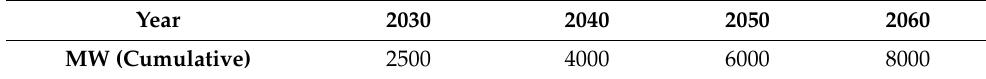
Table 1. Minimum cumulative MW of new wind generation until 2060